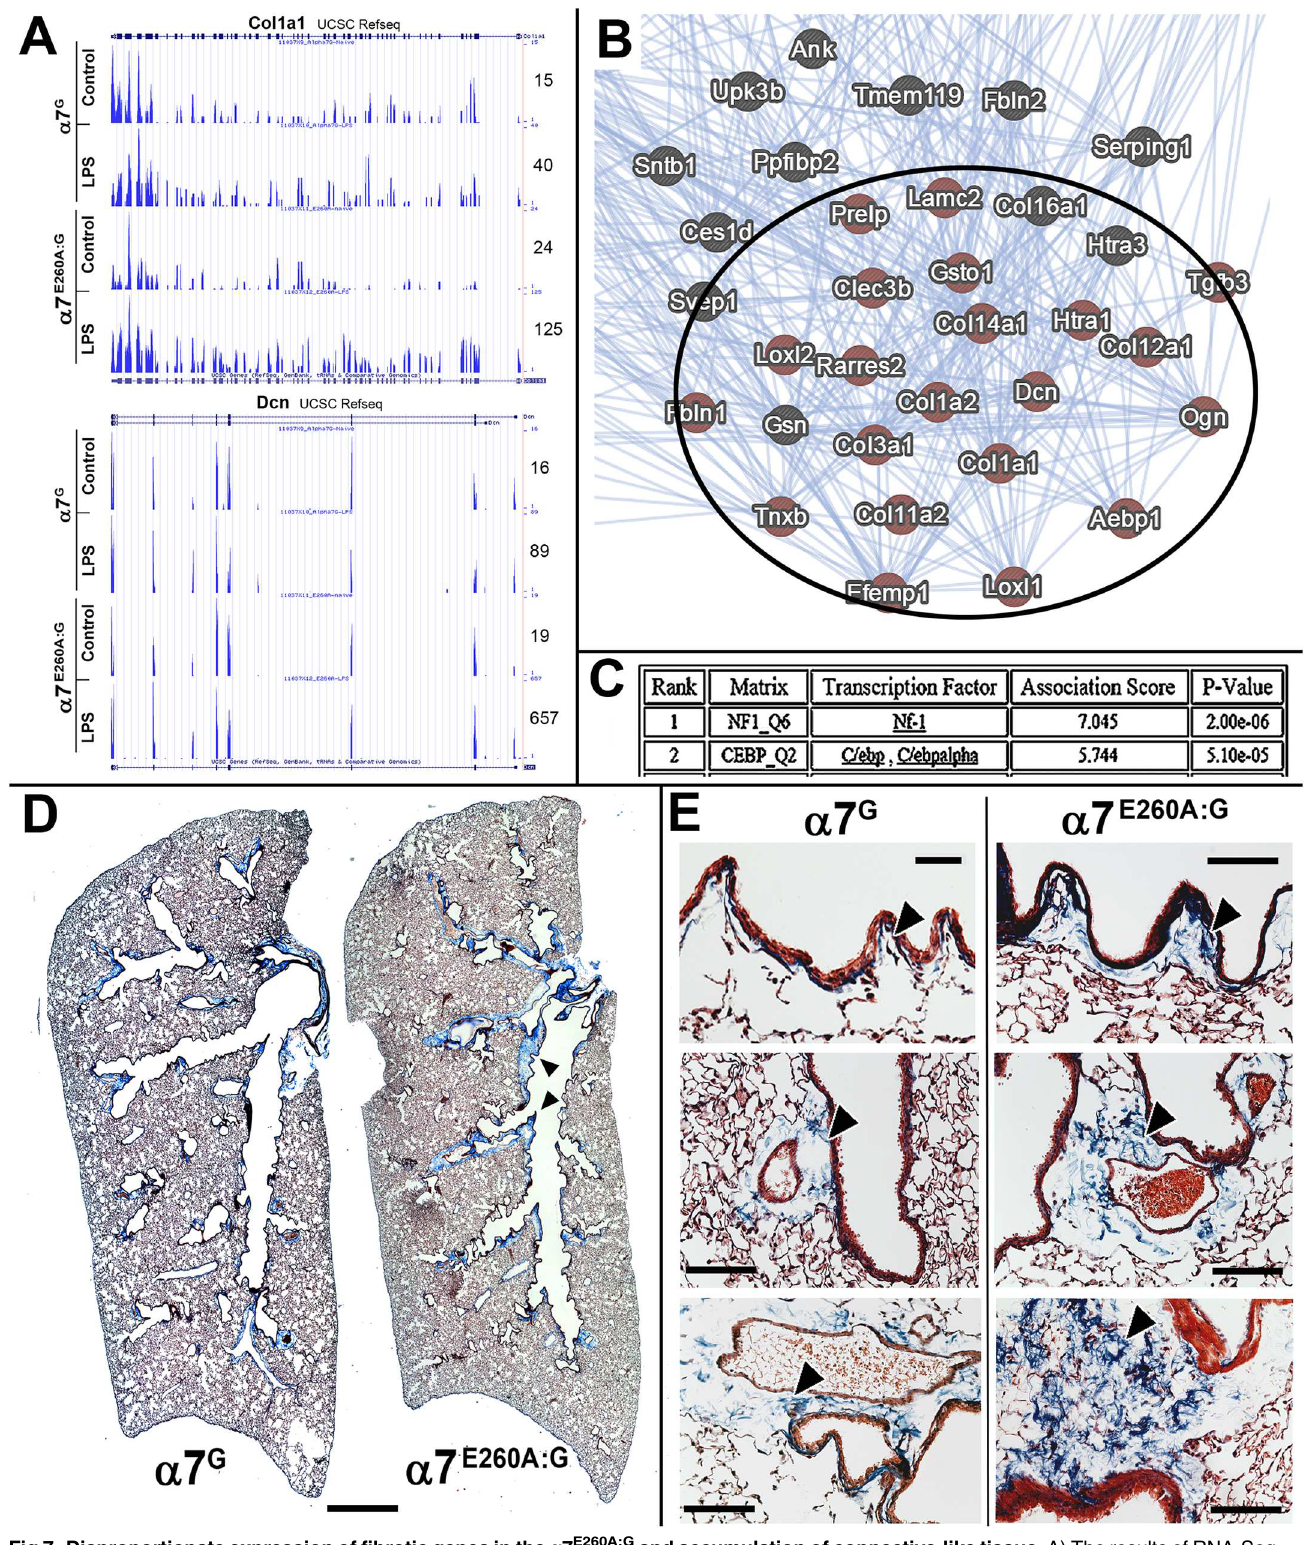
Fig 7. Disproportionate expression of fibrotic genes in the α 7 E260A:G and accumulation of connective-like tissue. A) The results of RNA-Seq reveal enhanced expressionin the α 7 E260A:G lung and disproportionate increasesin their responseto LPS relative to controls. Examplesof this are